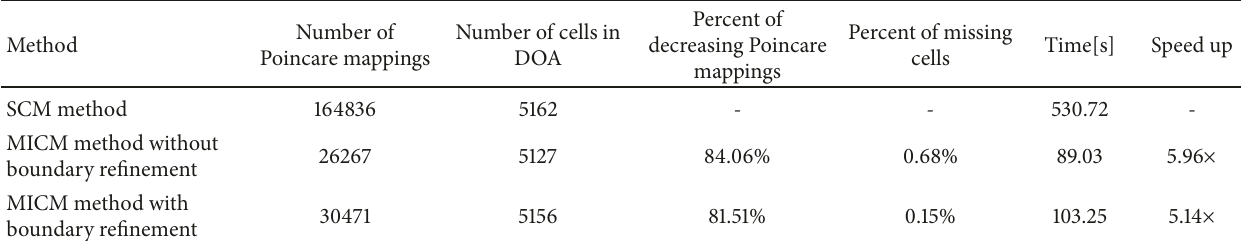
Table 2: Comparison between SCM method and MICM method for estimating the DOA of